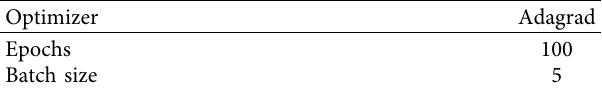
Figure 6: The structure of DBN. Table 6: LSTM samples’ performance.